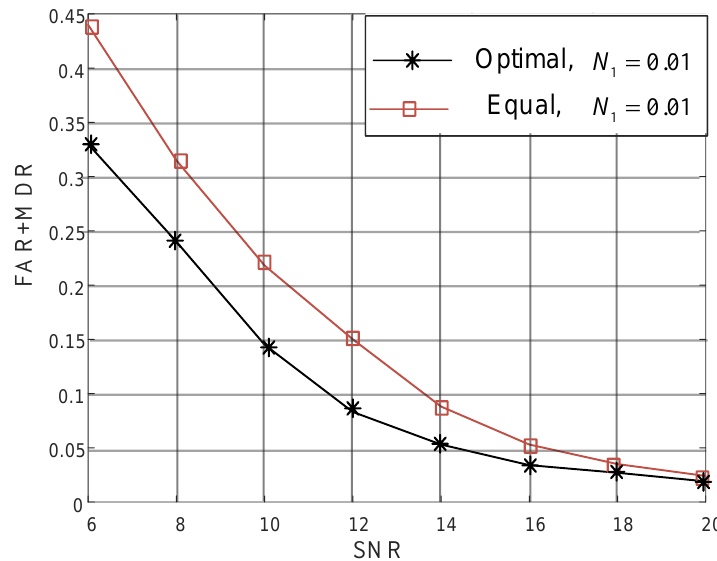
Figure 6. Performance comparison of two allocation